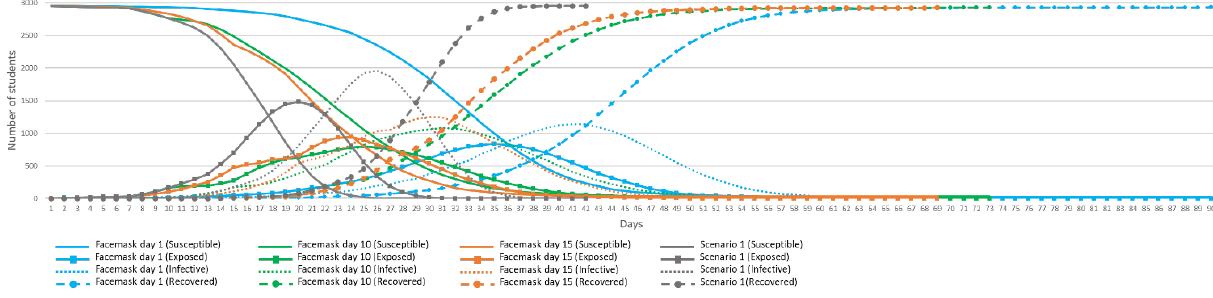
Figure A1. Comparison of the evolution of the disease between Scenarios 2 (Facemask Use) against Scenario 1 (No Measures).